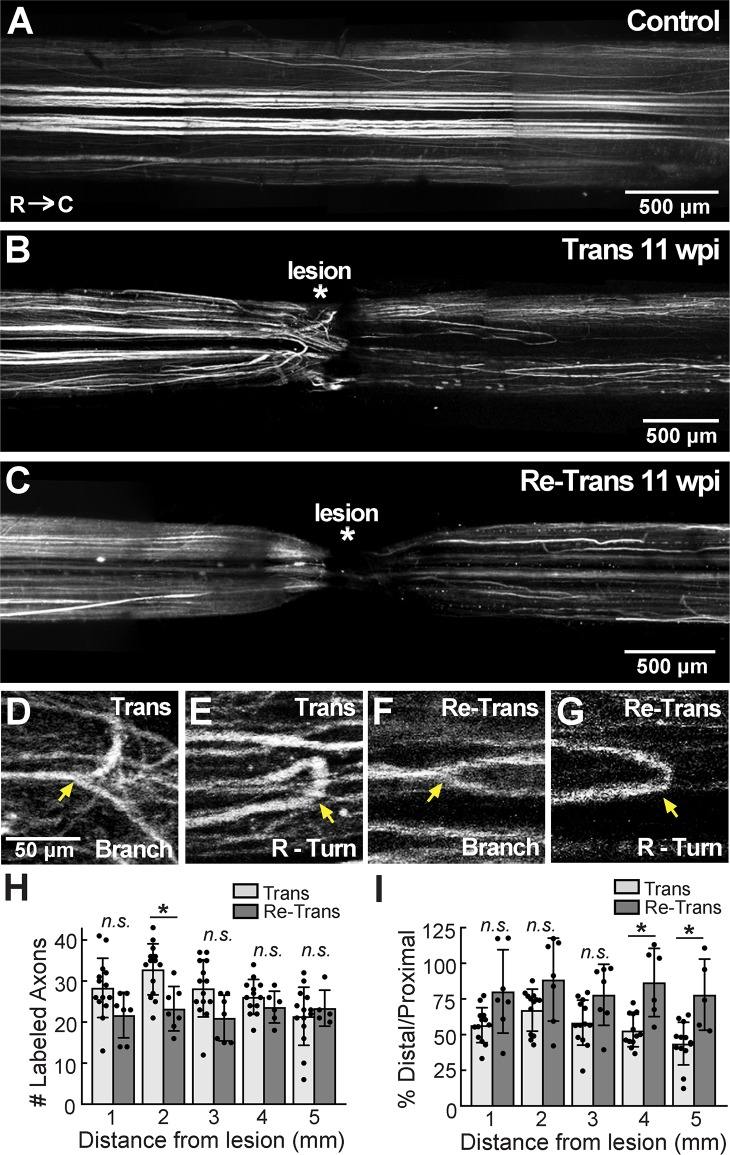
Axon regeneration in the lamprey spinal cord is comparable after repeated transections.(A) A montage of confocal z-projections showing bulk labeled axons in the uninjured, control spinal cord. Axons were labeled with 10 kDa Alexa-Fluor 488 dextran. Note the straight axonal projection patterns. (B-C) In contrast, at 11 wpi regenerated axons in the transected and re-transected spinal cords were sparser, and they exhibited atypical projection patterns in the medial and lateral tracts. (D-G) Higher magnification confocal images showing axonal branching and rostral turning (R-Turn) in transected and re-transected spinal cords (arrows) at 11 wpi. Scale bar in D applies to E-G. Rostral is to the left in all images. (H) In general, the number of labeled, axons was similar in transected and re-transected spinal cords. Bars represent mean ± SD from n = 7–14 spinal cords. n.s. = not significant; * indicates p<0.05 by ANOVA. (I) The percentage of distal/proximal labeled axons was slightly higher in re-transected spinal cords. Bars represent mean ± SD from n = 7–14 spinal cords. n.s. = not significant; * indicates p<0.05 by ANOVA.